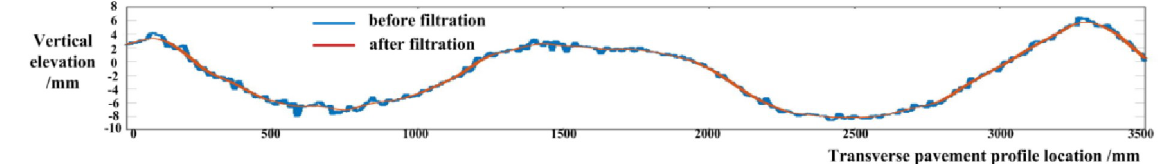
Fig 3. Rut profile before and after